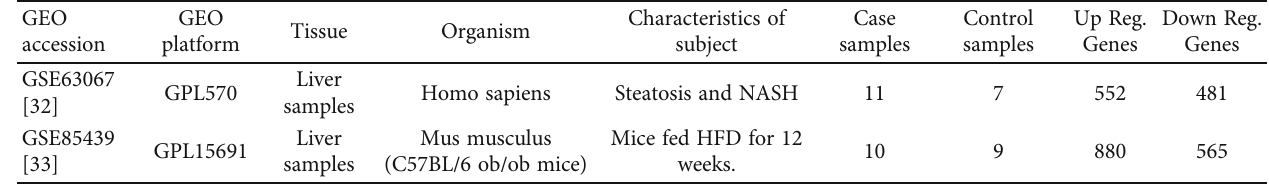
Table 1: The di ff erentially expressed gene (DEG) for all employed Datasets in the present study.